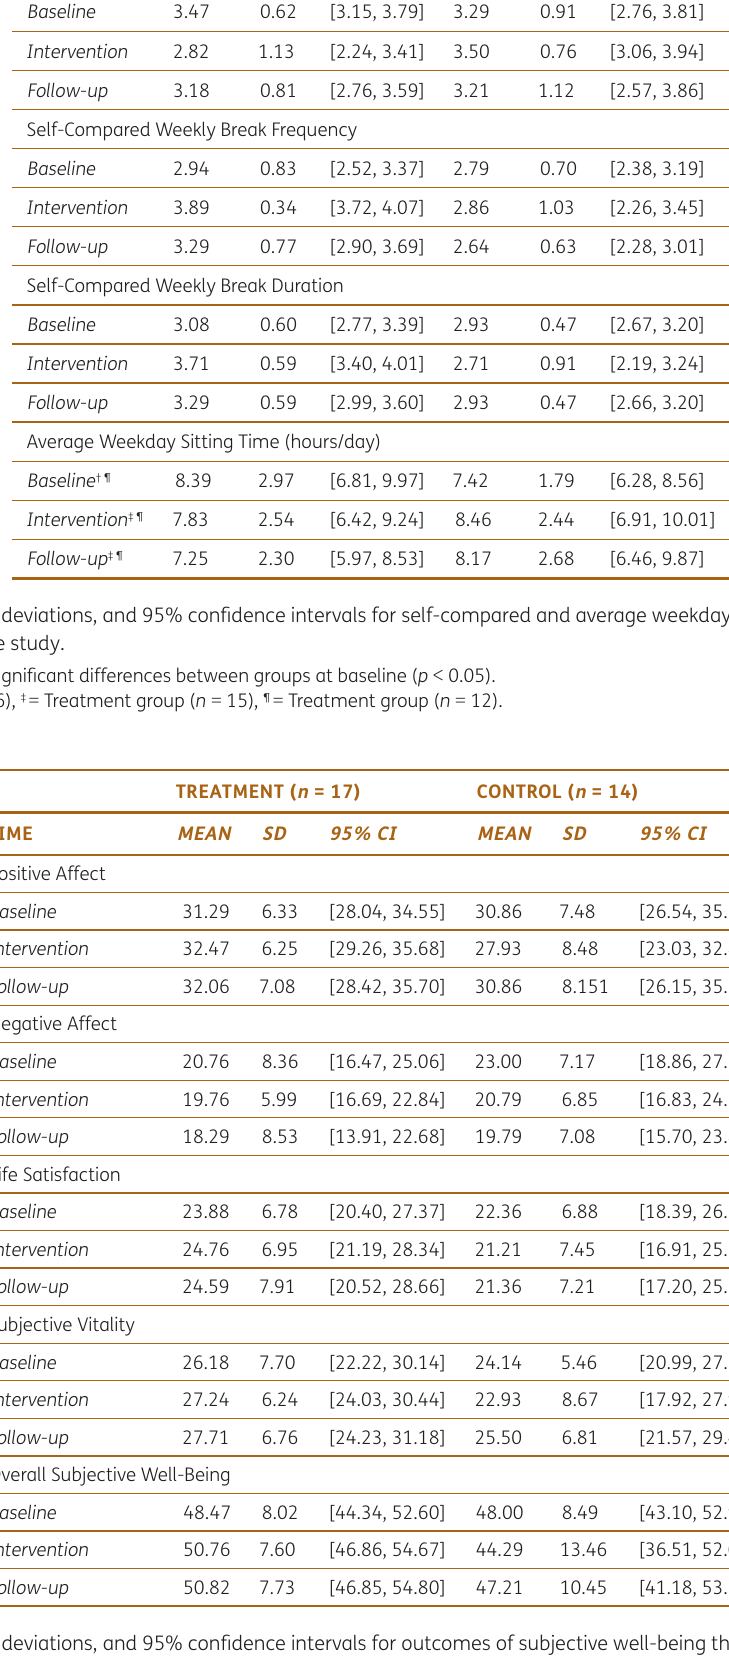
Table 4 Means, standard deviations, and 95% confidence intervals for outcomes of subjective well-being throughout the study. Note: Bold text indicates significant differences between groups at baseline ( p < 0.05).